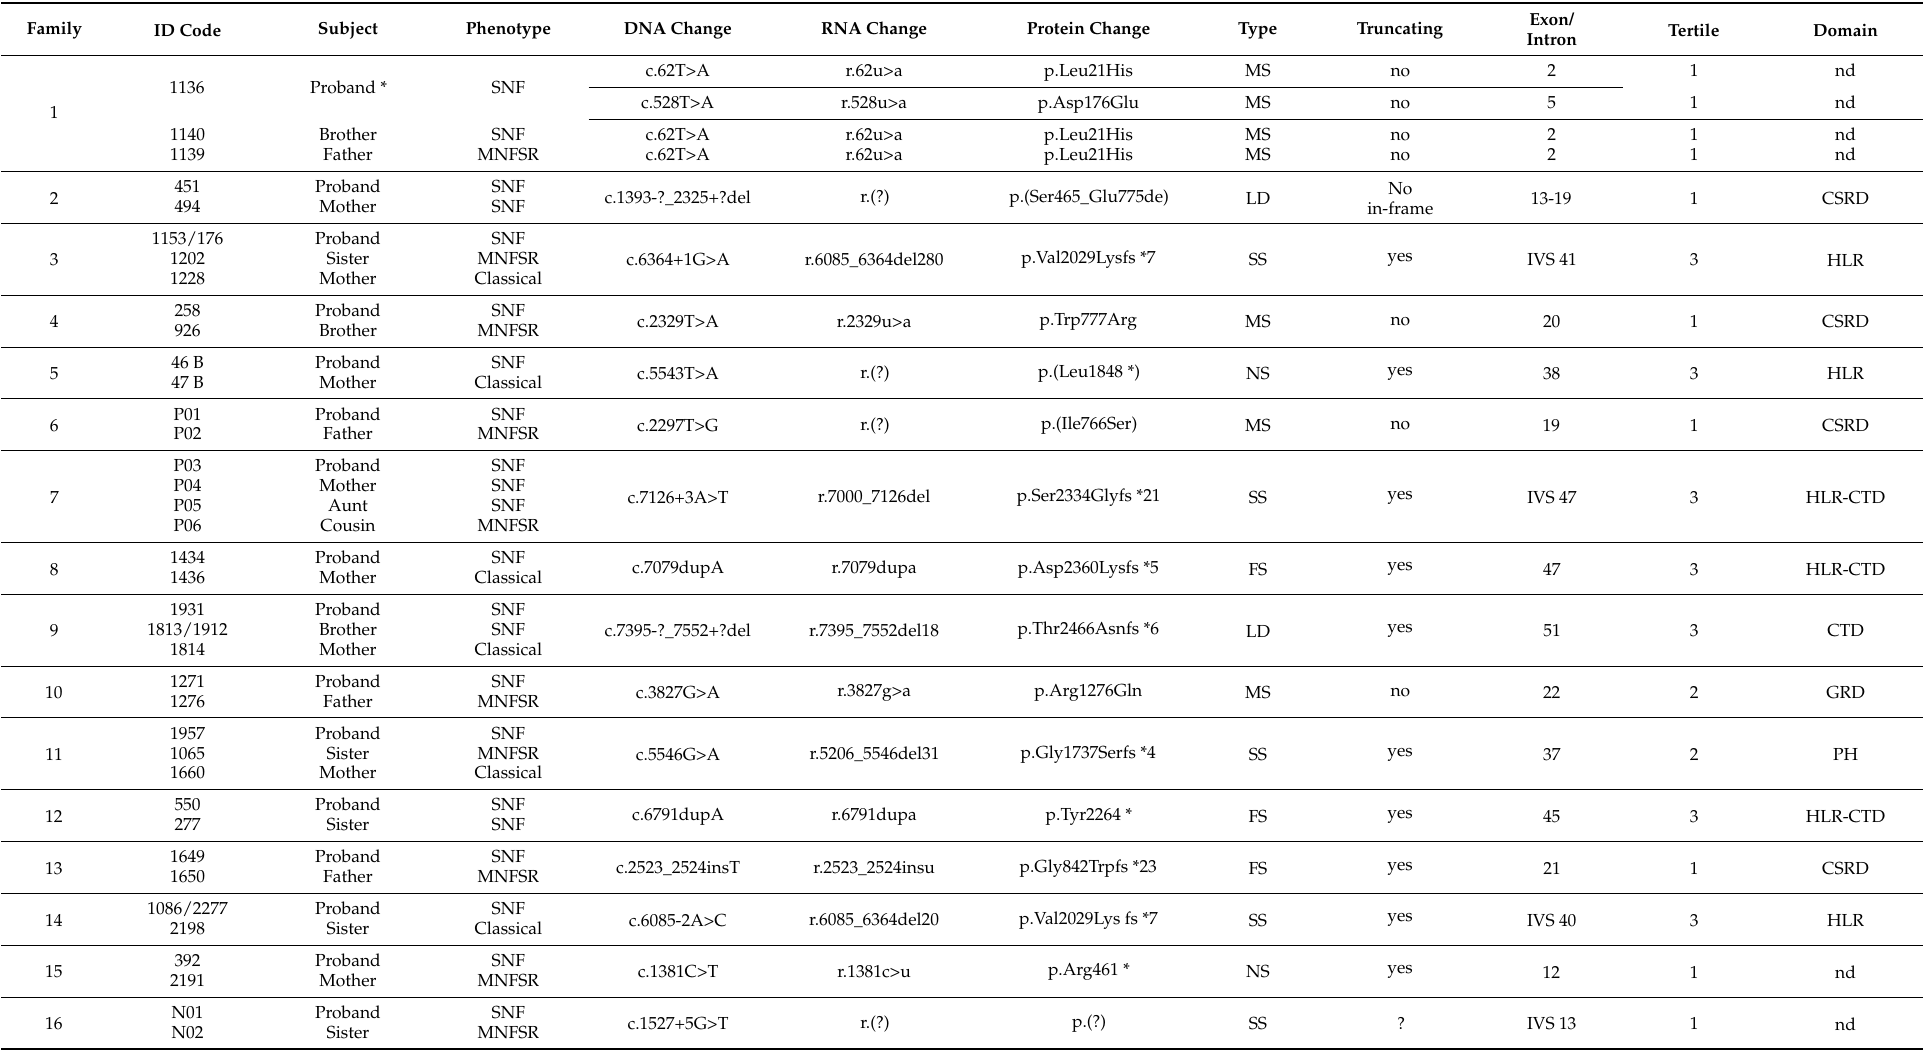
Table 3. NF1 variants observed in 19 families with at least 1 SNF